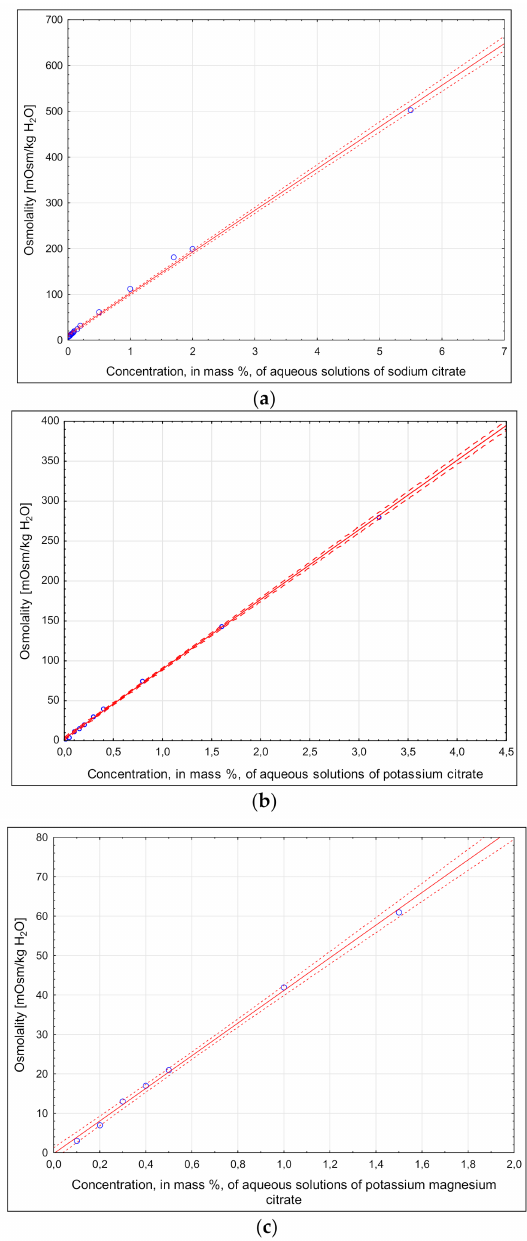
Figure 4. Electrolyte osmolalities in aqueous solution. ( a ) Sodium citrate: Osmolality = 10.58 + 91.04 × Concentration; r 2 = 0.999.( b ) Potassium citrate: Osmolality = 2.52 + 87.19 × Concentration; r 2 = 0.999. ( c ) Magnesium citrate: Osmolality = − 0.23 + 41.40 × Concentration; r 2 =